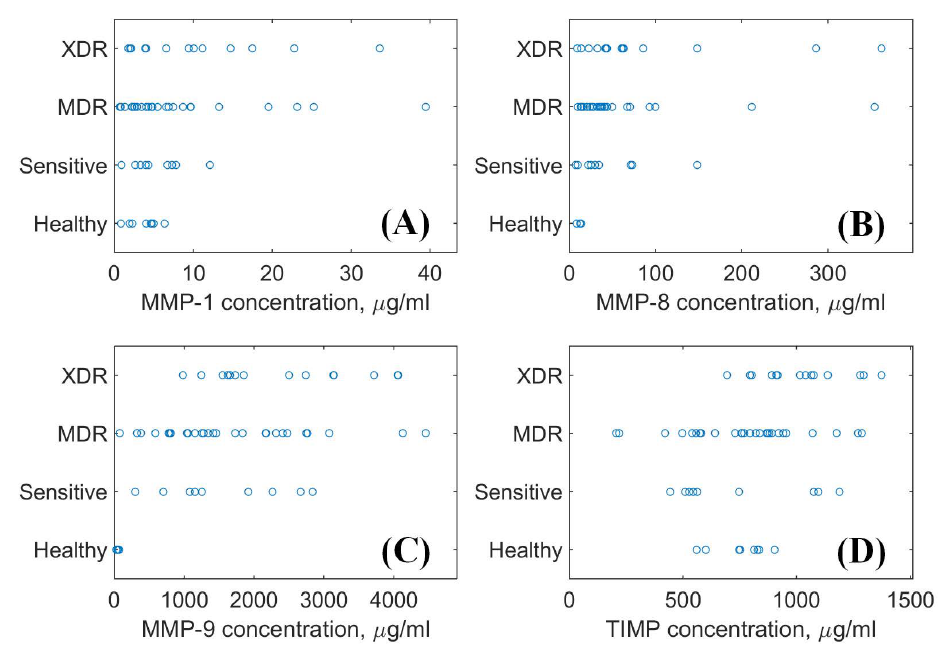
Figure 1. The distribution of the biomarker (( A ): MMP-1, ( B ): MMP-8, ( C ): MMP-9, ( D ): TIMP) concentrations sorted with respect to the drug resistance status. The data are taken from the freely available source [16] (published under the Creative Commons Attribution (CC BY)